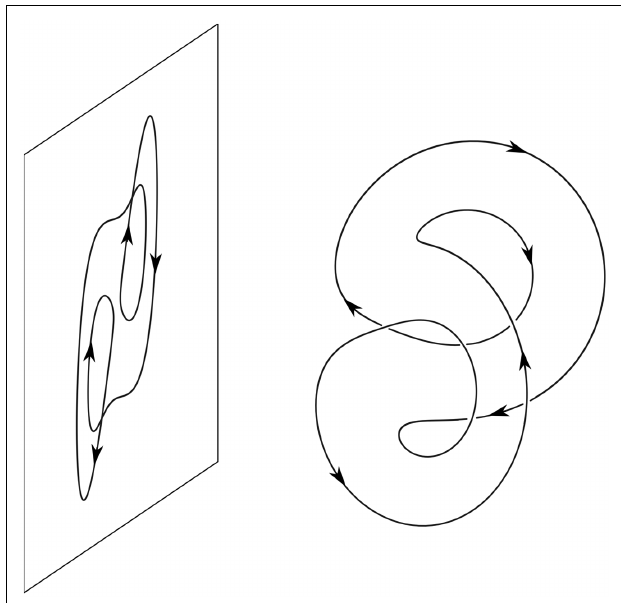
FIGURE 6 |A loop-shaped orbit in R 3 projected to a two-dimensional subspace. The loop in R 3 does not cross itself, but its projection does, twice.The orbit is taken from the Lorenz equation, for a parameter value near one of its many